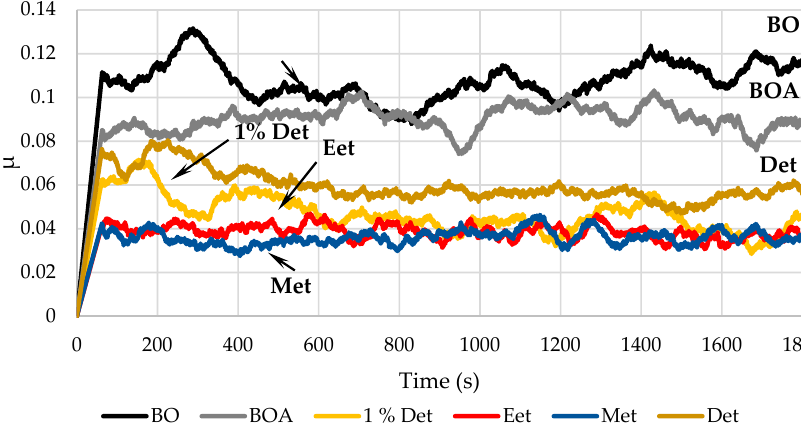
Figure 5. Friction vs. time curves of BO, BOA, 1 wt.% Det + BO, Eet, Met, and Det.